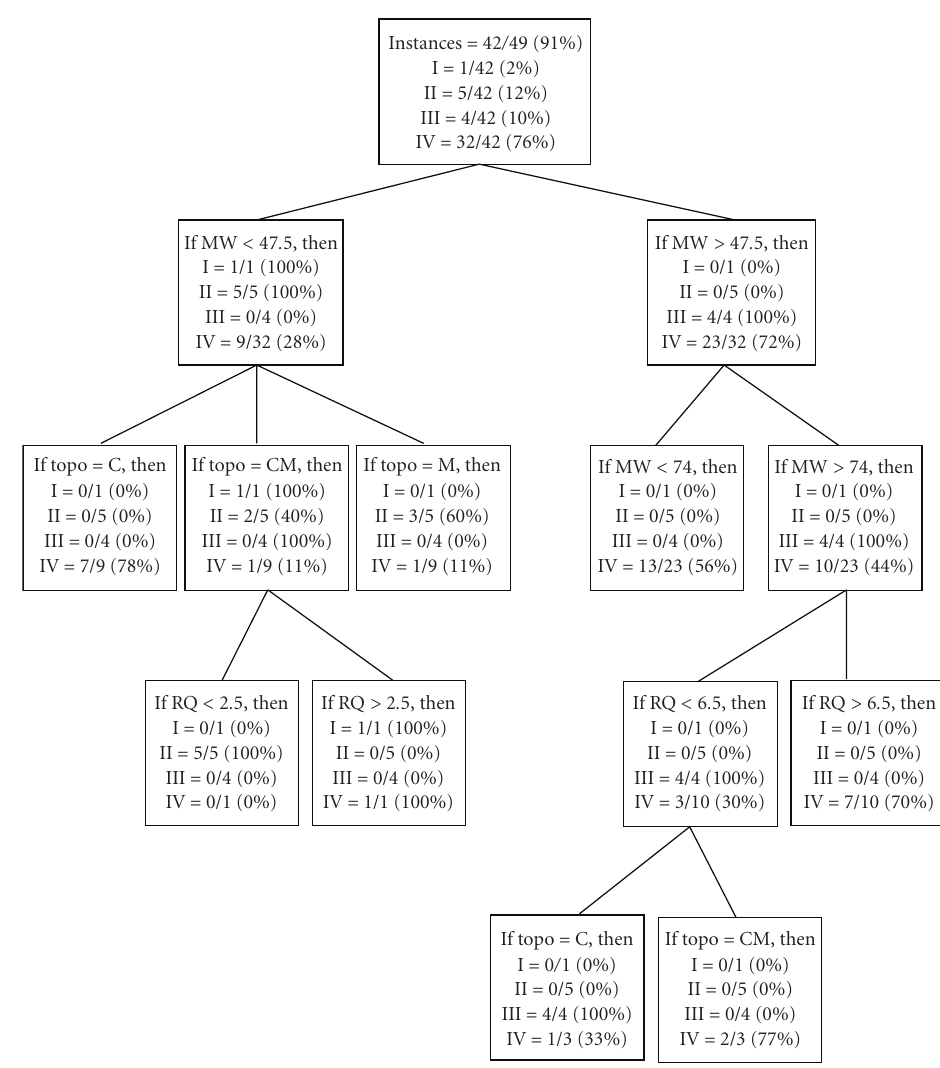
Figure 5: Decision tree analysis according to Dpl characterization in astrocytoma specimens. The adopted Dpl-based criteria at the decision nodes are reported (i.e. molecular mass of Dpl isoforms, MW; relative quantity of Dpl expression, RQ; Dpl topology, C = cytosol, M = microsomal or CM = both). WHO grading and sample percentages are